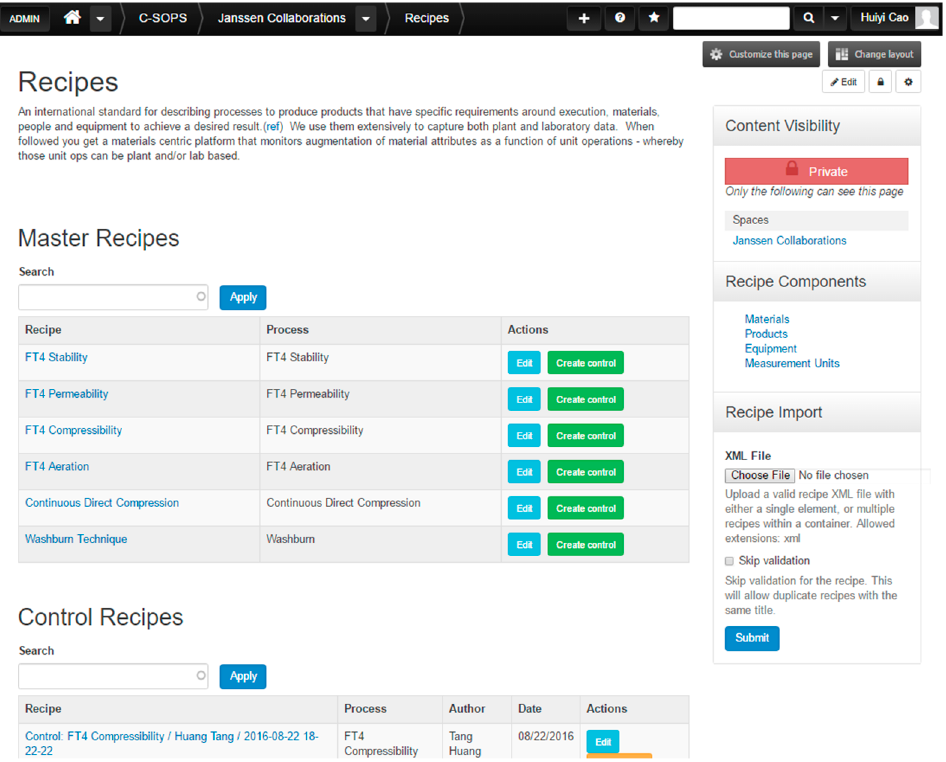
Figure 13. The web interface of ELN system.